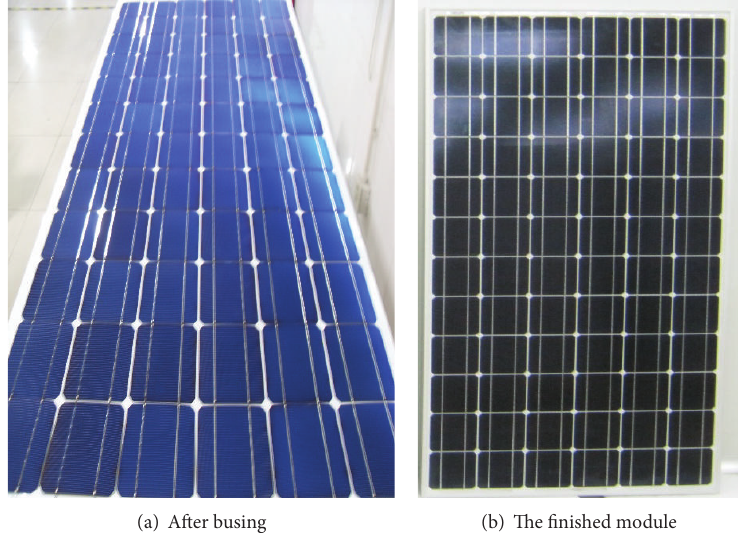
Figure 1: The solar module after busing and the finished